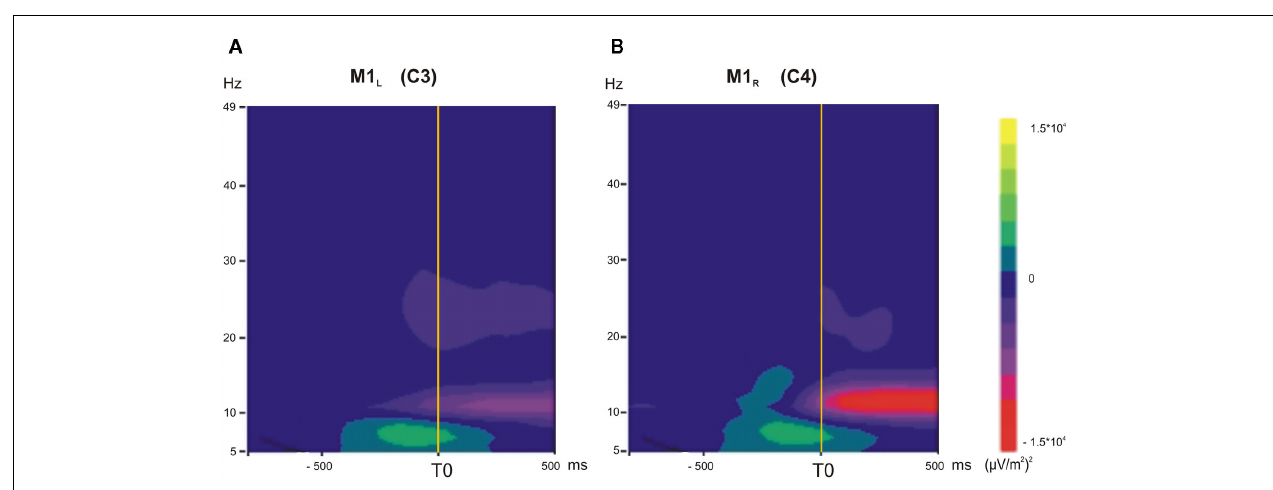
FIGURE 2 | (A,B)Time–frequency (TF) analysis in the 5- to 49-Hz frequency range, grand average across subjects in the voluntary situation ( − 1000 to + 500ms). (A) M1 L , left primary motor cortex. (B) M1 R , right primary motor cortex. A transient diminution in the 10- to 13-Hz frequency range occurred for M1 L and M1 R just beforeT0 and during